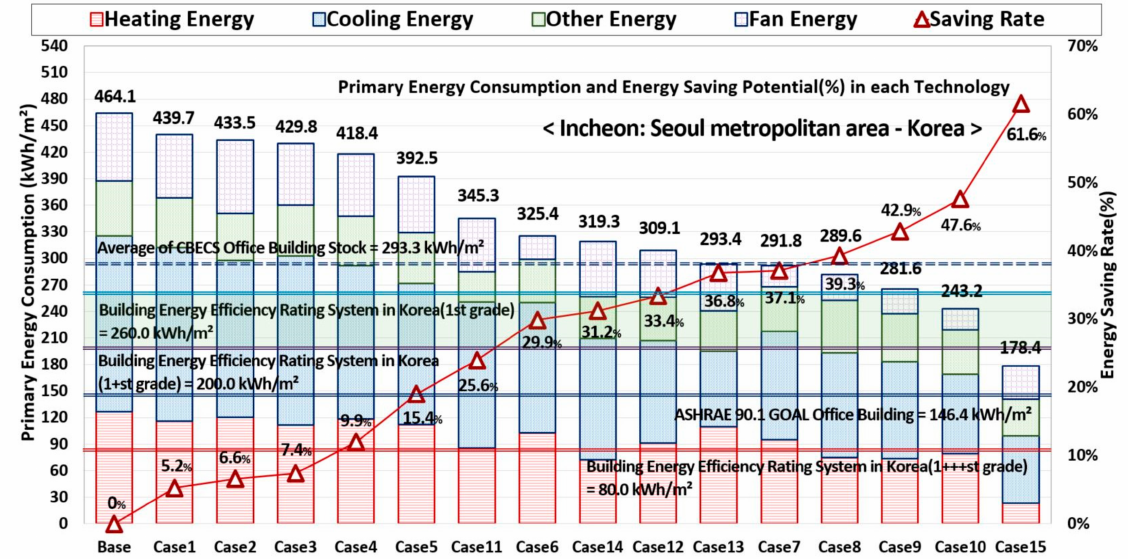
Figure 9. Primary energy consumption values and energy saving potential (%) in each